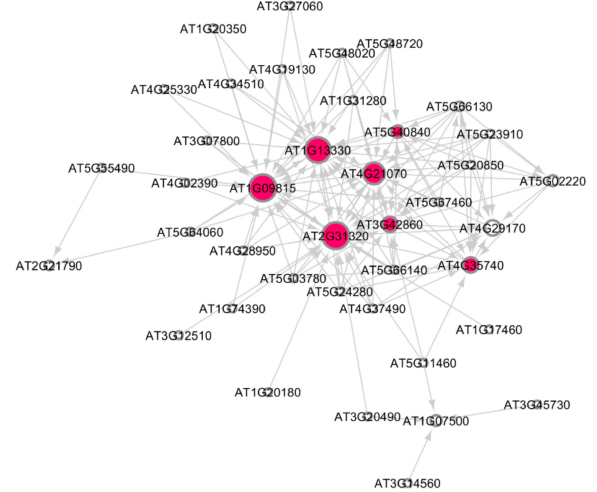
Figure 5. Subnetwork for DNA metabolic process in Arabidopsis under very high HZE radiation dose. Hub genes are indicated by red circles. There are seven significant hub genes in this subnetwork. Larger the circles, higher the activation of the hub genes.